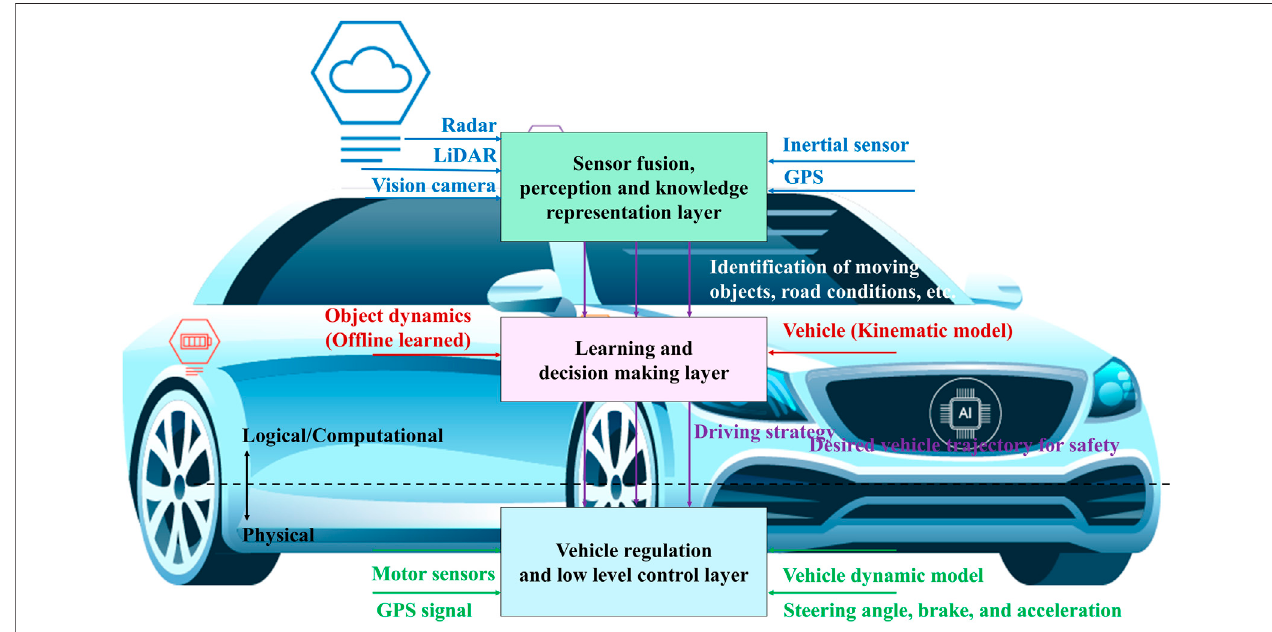
FIGURE 7 | Layered AI-based processing and cognition in ECAS